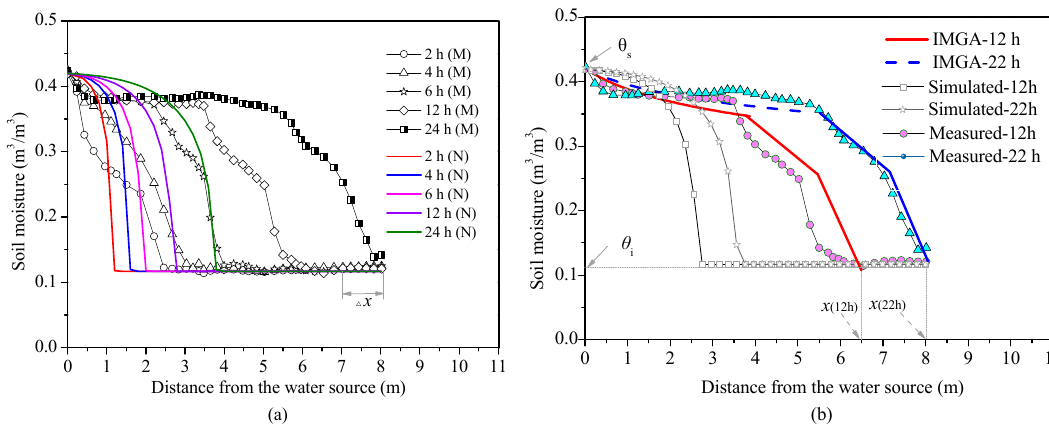
Figure 12. Soil moisture profile comparison: ( a ) wetting front comparison between actually measured values (M) and numerical solutions (N) of Richards’ equation, and ( b ) soil moisture profile comparison among the IMGA model, solutions of Richards’ equation and actually measured values.